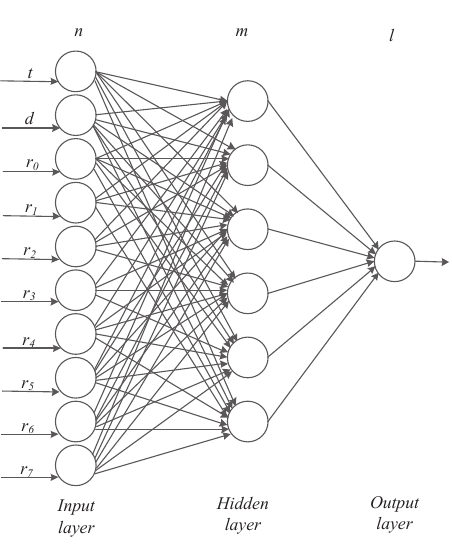
Figure 7. BP Neural Network